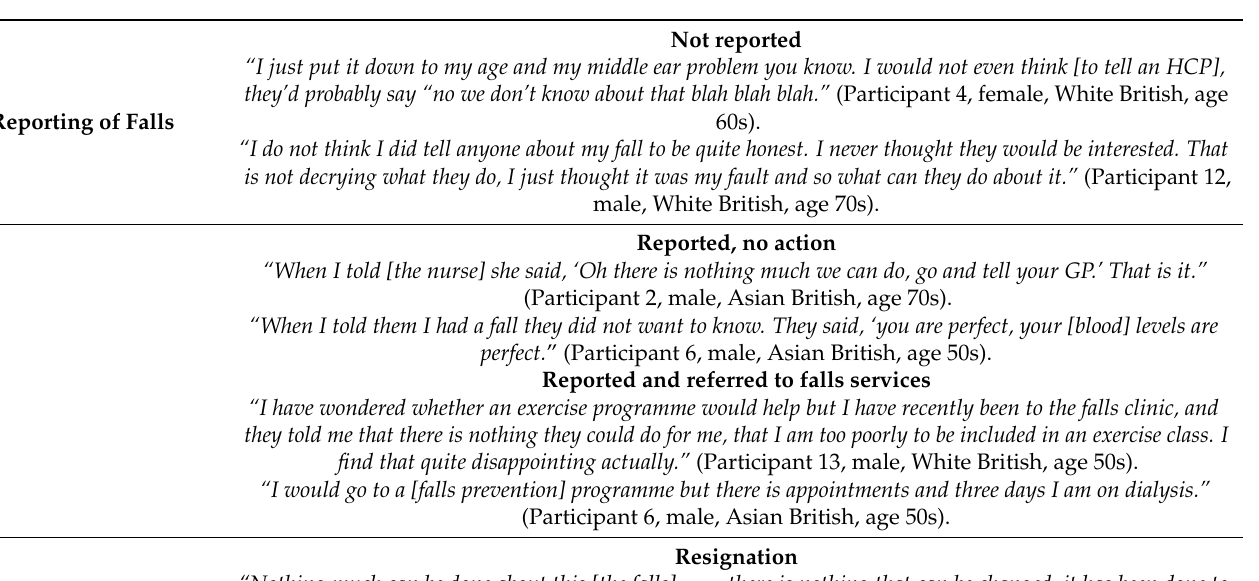
Table 4. Quotations illustrating participants’ attitudes to the reporting of falls and how they cope with